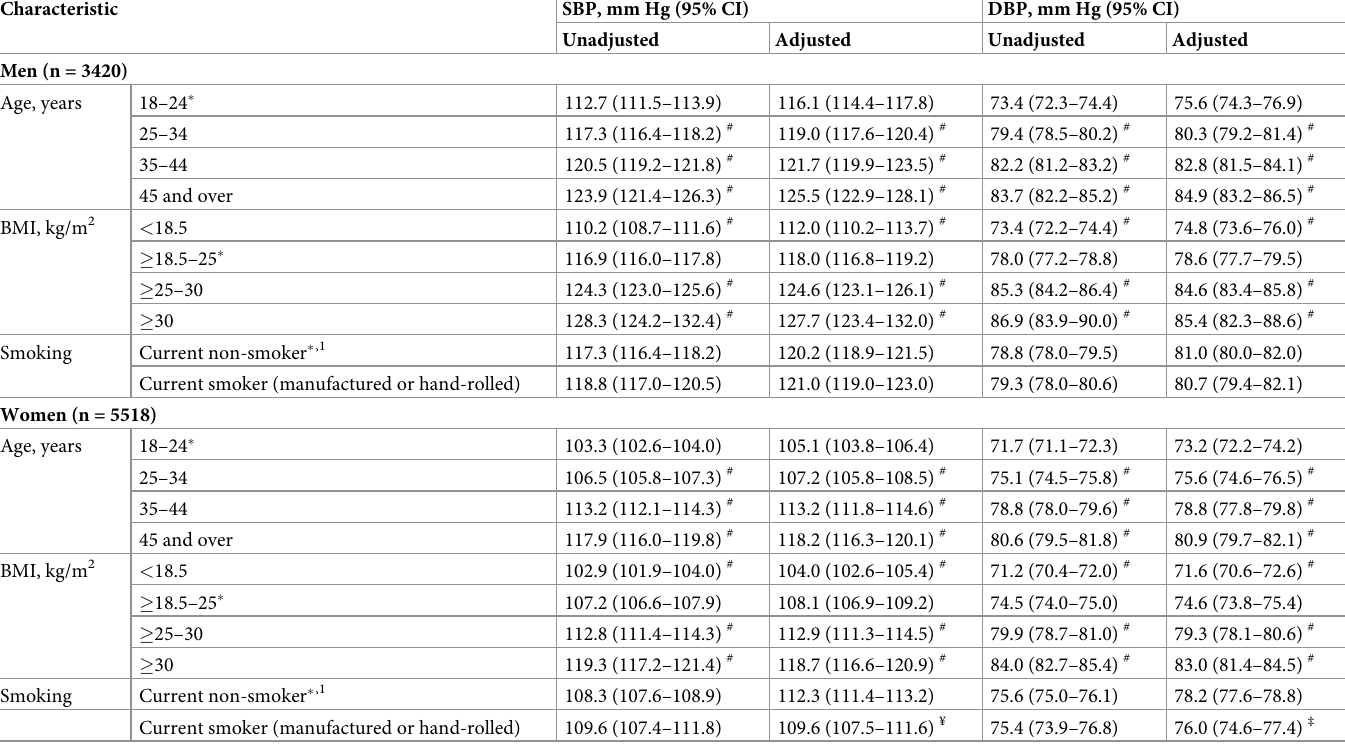
Table 4. Mean SBP and DBP: Unadjusted and adjusted for age, BMI, wealth quintile and agricultural occupation.